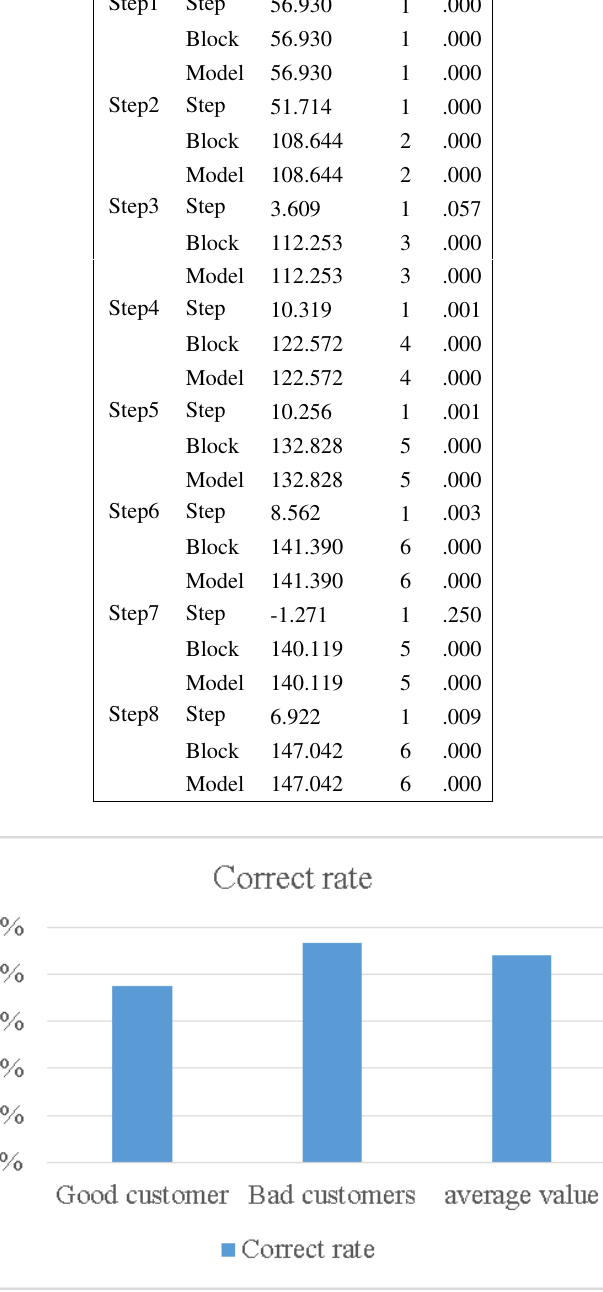
Fig. 1 The prediction accuracy of the model when the cut-off point is